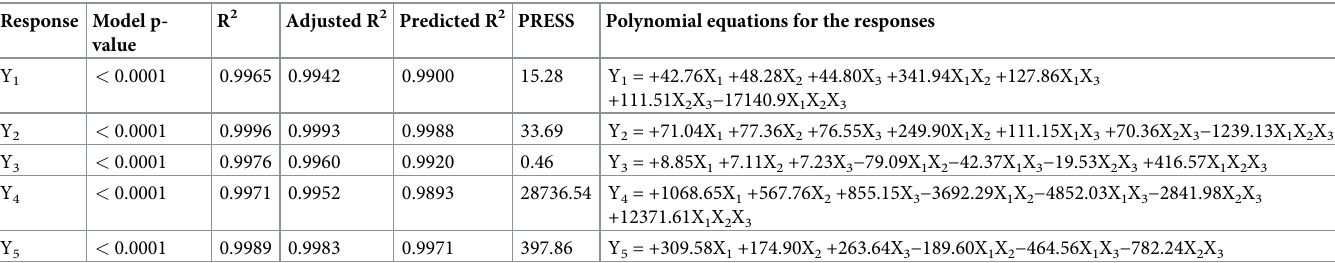
Table 3. Statistical parameters for the measured